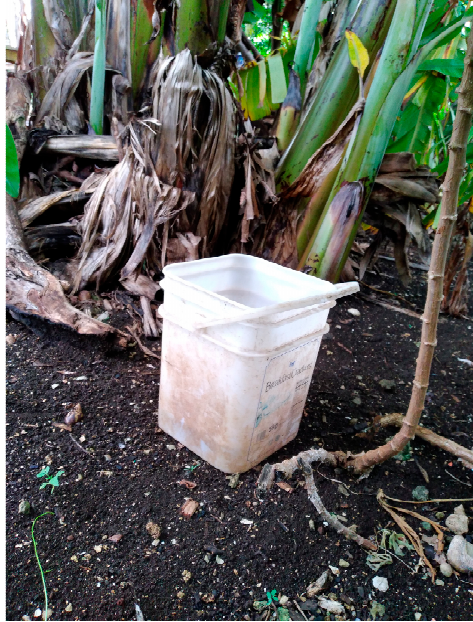
Figure 2. No privacy . Photo caption: In [our uncle’s] house, there is no privacy. Therefore, when